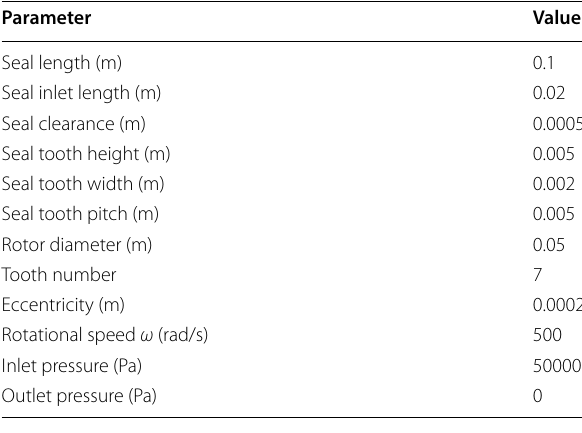
Table 3 Boundary